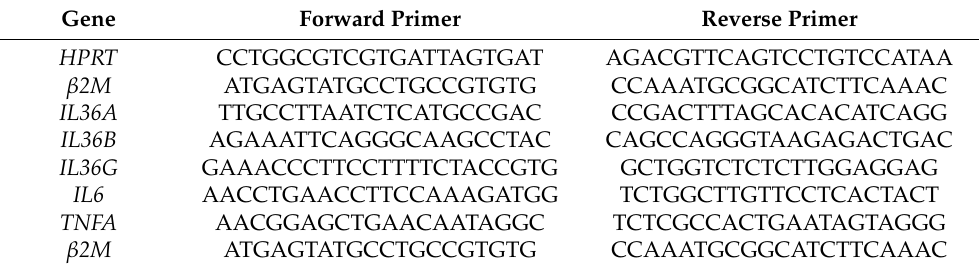
Table 1. Primer sequences used for RT-qPCR.